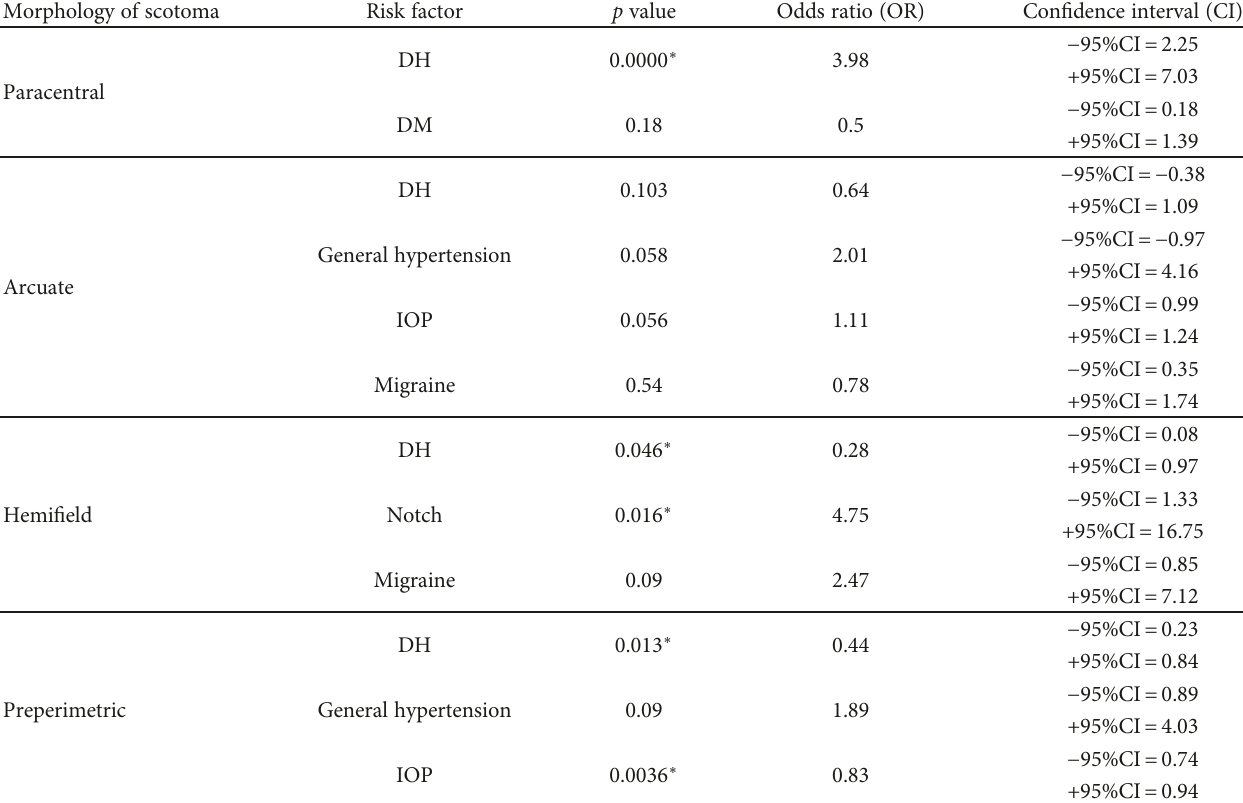
Table 4: Logistic regression analysis of morphology of the scotoma with risk